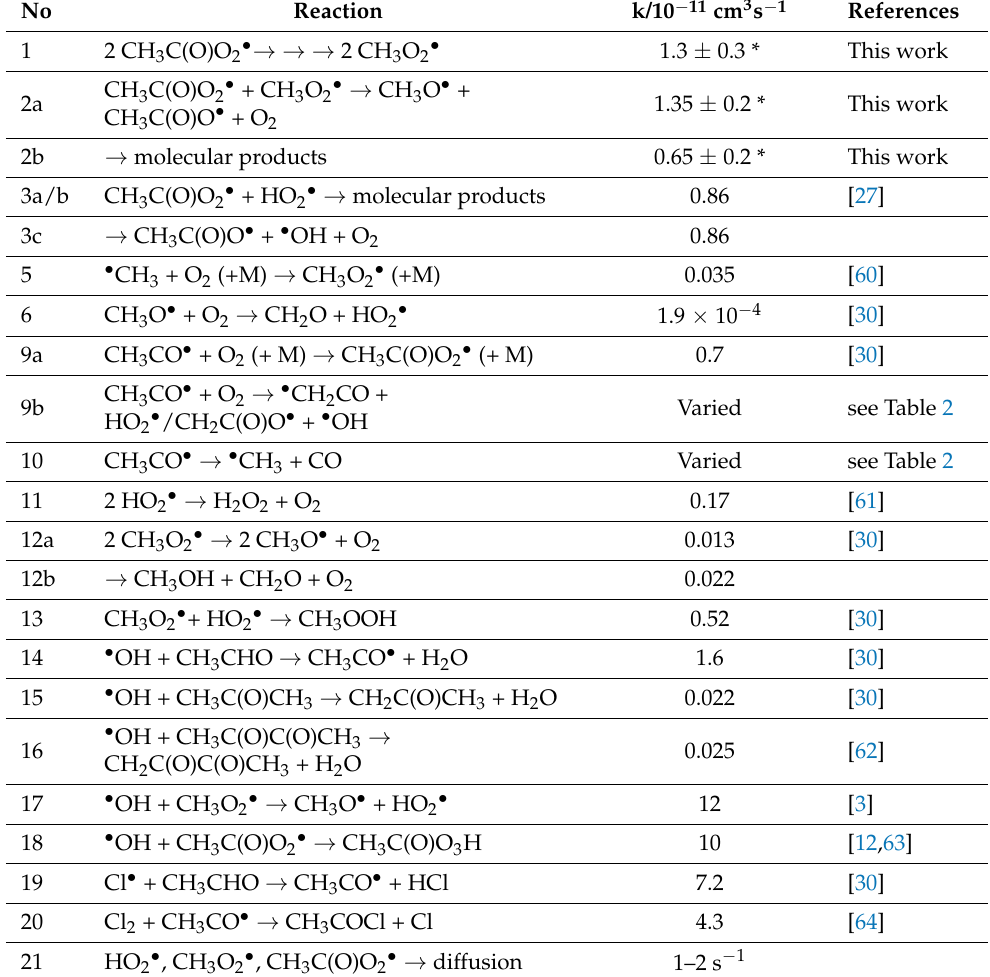
Table 3. Mechanism used for fitting the different profiles under all